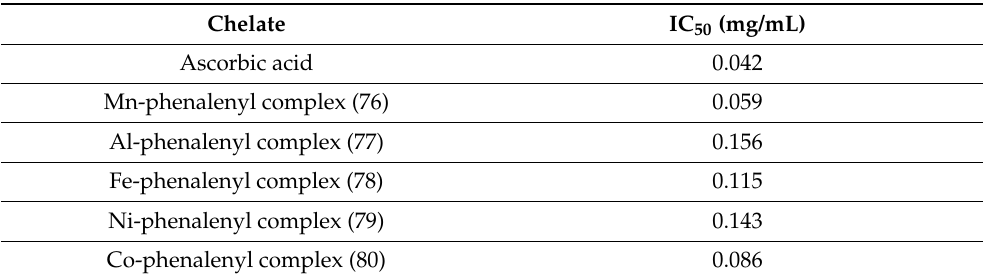
Table 5. DPPH scavenging ability (IC 50 , mg/mL) of the reference (ascorbic acid) and the metal-PLY chelates